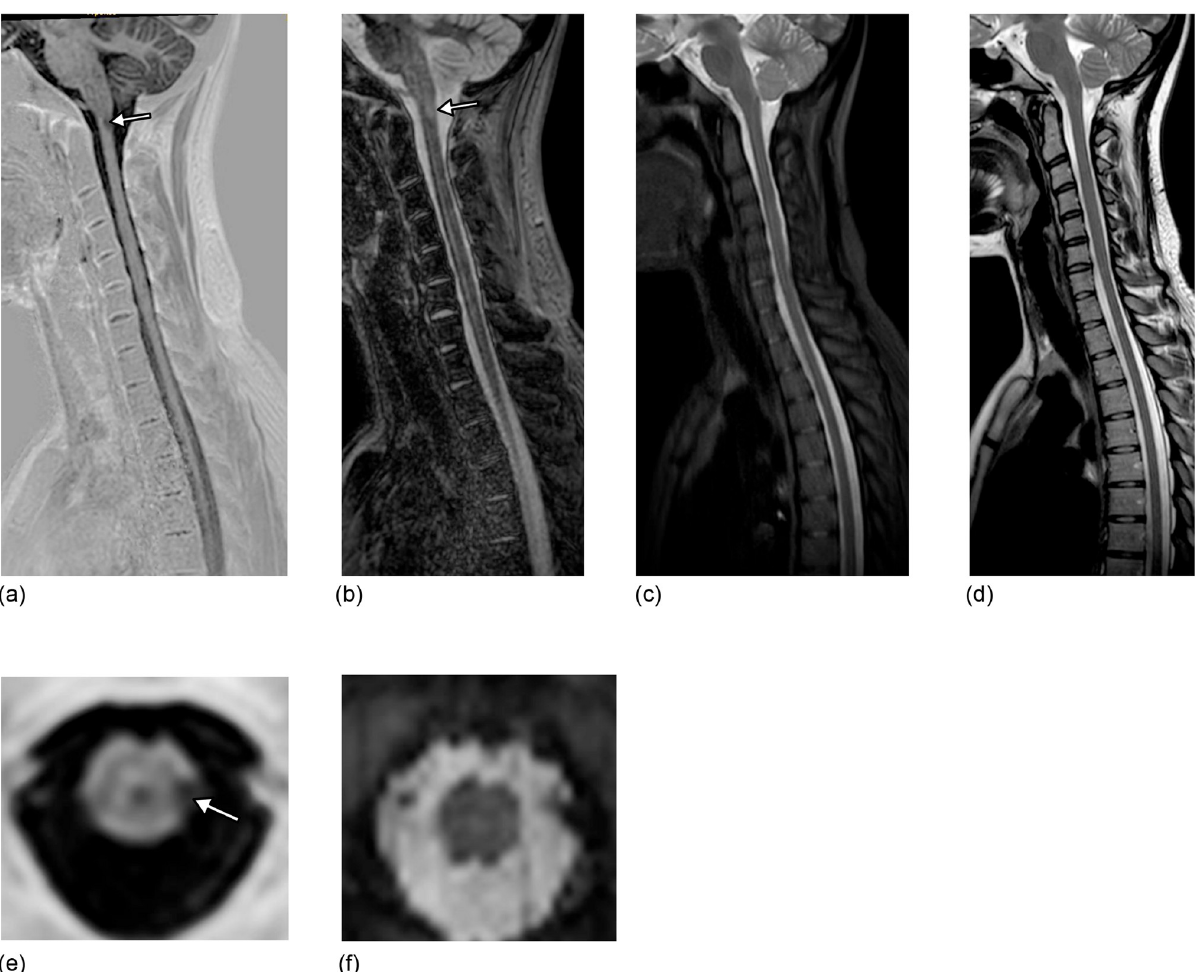
Fig 2. A 23 year-old man with relapsing-remitting multiple sclerosis. 3D-Fast Gray Matter Acquisition with Phase Sensitive Inversion Recovery (3D-FGAPSIR) real-corrected (a) and second magnitude (b) images reformatted in the sagittal plane showing a single left posterior cervical spinal cord lesion (arrow), whereas no lesion was detected on both 3D-Short-Tau Inversion Recovery (STIR) reformatted in the sagittal plane (c) or sagittal T2-weighted imaging (d). 3D-FGAPSIR real-corrected image reformatted in the axial plane (e) confirming and precisely localizing the lesion, whereas no lesion was detected on 3D-STIR reformatted in the axial plane